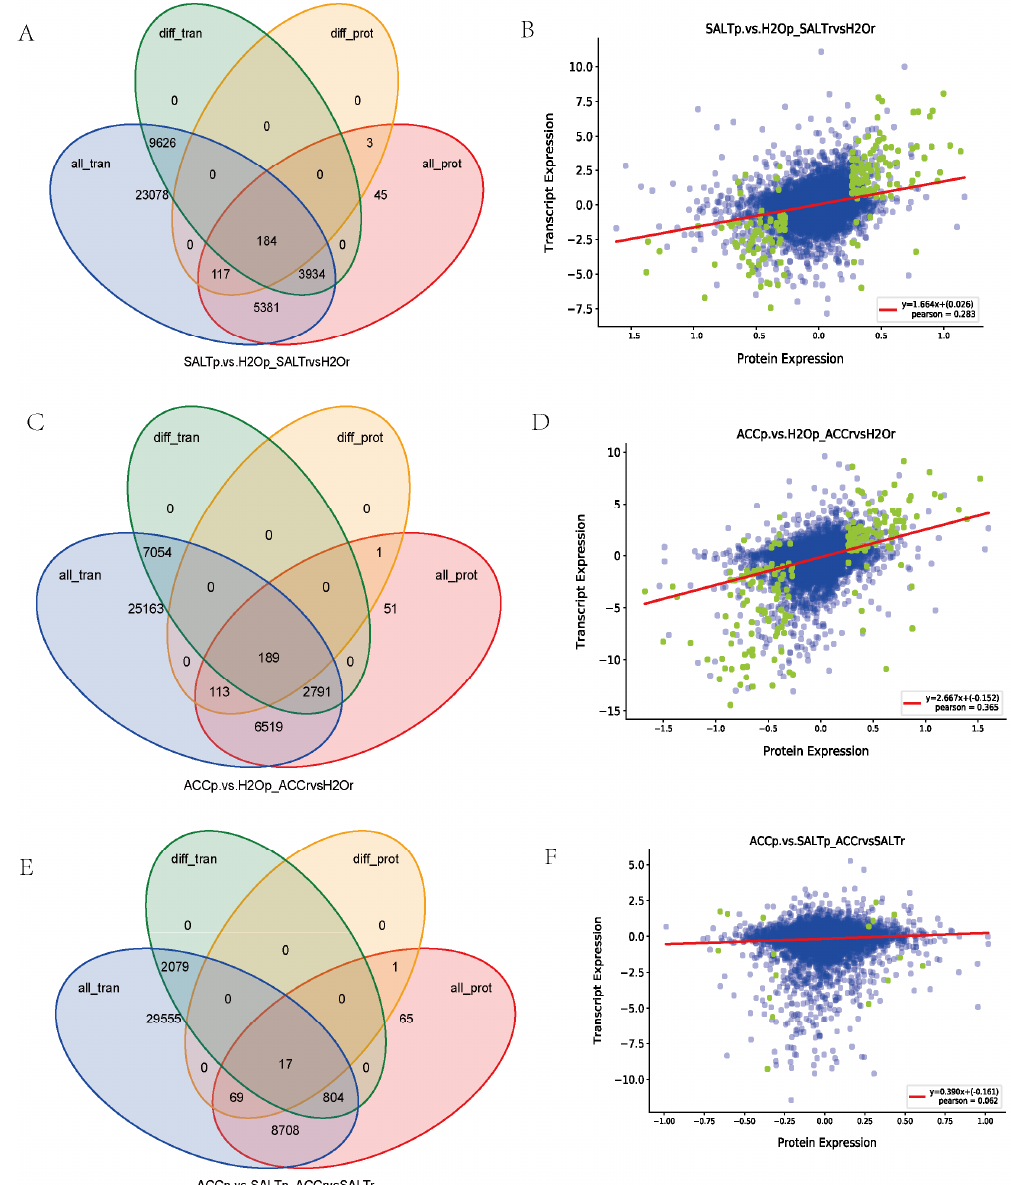
Figure 3. The correlation analysis between proteome and transcriptome by Venn diagrams and scatter plot of expression correlation. ( A , C , E ) tVenn diagrams of genes, proteins, DEGs, and DEPs between SALT and H 2 O samples ( A ), between ACC and H 2 O samples ( C ), and between ACC and SALT samples ( E ), respectively; all_tran represents all the genes obtained from the transcriptome, diff_tran represents the DEGs identified by transcriptome, all_prot represents all the proteins identified by proteome, and diff_prot represents the DEPs identified by proteome. ( B , D , F ) Scatter plots of expression correlation between SALT and H 2 O samples ( B ) between ACC and H 2 O samples ( D ) and between ACC and SALT samples ( F ), respectively. The abscissa is the differential multiple of proteins, the ordinate is the differential multiple of corresponding genes, and the correlation coefficient and p value of the transcriptome and proteome are also shown in the figures. The points represent proteins/genes: the blue points represent non-differential proteins/genes, and the green points represent DEPs/DEGs.